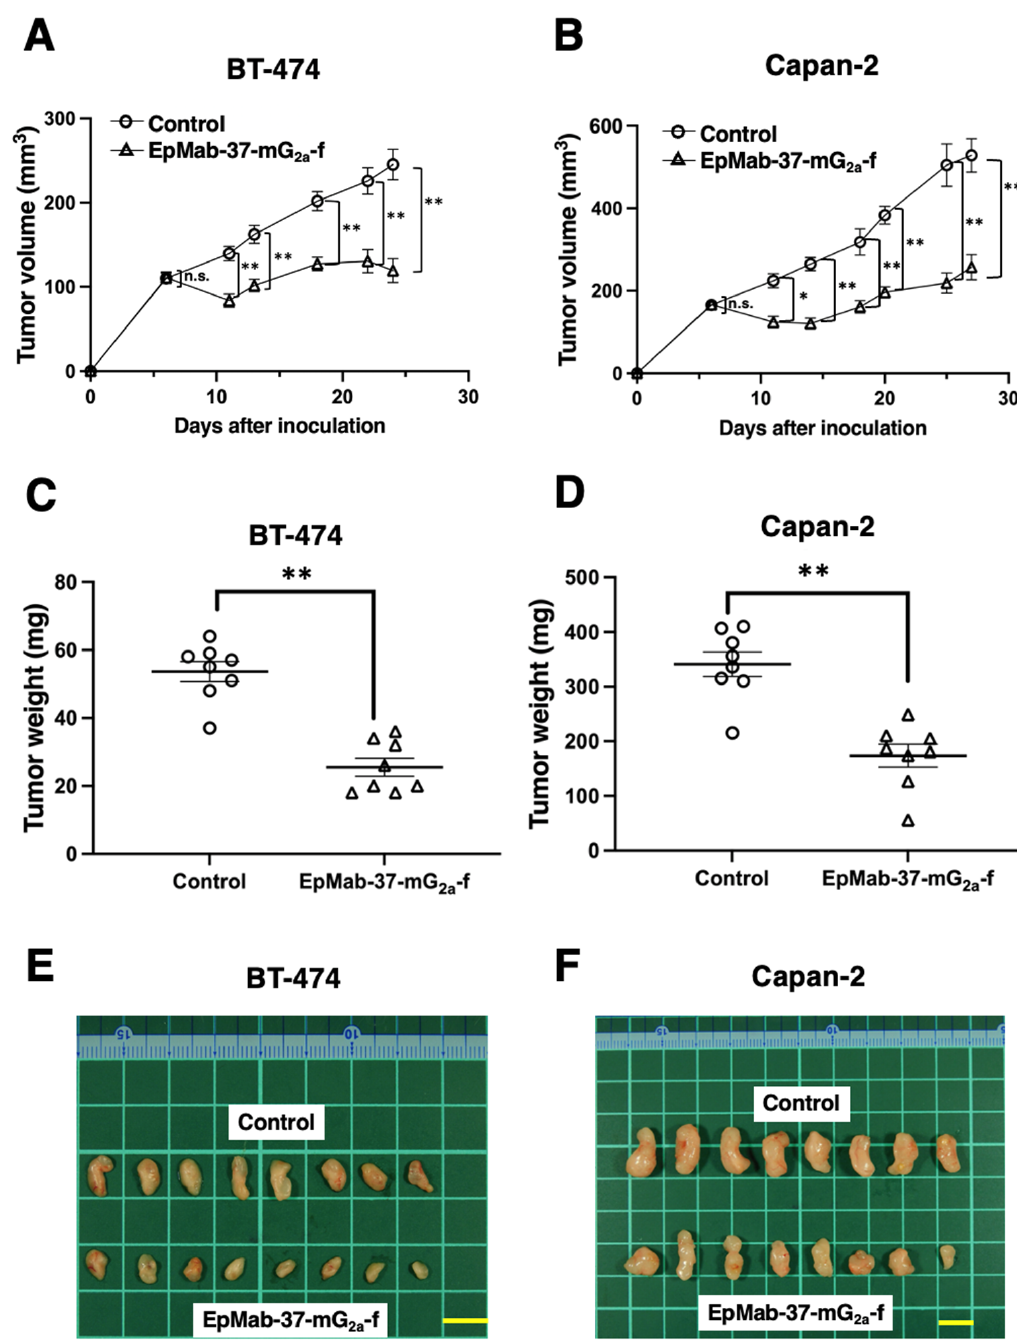
Figure 4. Antitumor activity of EpMab-37-mG 2a -f. ( A , B ) Measurement of tumor volume in ( A ) BT-474 and ( B ) Capan-2 xenograft models. BT-474 and Capan-2 cells (5 × 10 6 cells) were inoculated into mice subcutaneously. On day six, 100 μg of EpMab-37-mG 2a -f or control mouse IgG were injected into mice intraperitoneally. On day 13 and 18 (BT-474) or 14 and 18 (Capan-2), additional antibodies were injected. On the indicated days after the inoculation, the tumor volume was measured. Values are presented as the mean ± SEM. ** p < 0.01, * p < 0.05 (ANOVA and Sidak’s multiple comparisons test). ( C , D ) The weight of excised ( C ) BT-474 and ( D ) Capan-2 xenografts was measured on day 24 and 27, respectively. Values are presented as the mean ± SEM. ** p < 0.01 (Welch’s t test). ( E , F ) The resected tumors appearance of ( E ) BT-474 and ( F ) Capan-2 xenografts in the control mouse IgG and EpMab-37-mG 2a -f treated groups on day 24 and 27, respectively (scale bar, 1 cm). n.s., not significant.